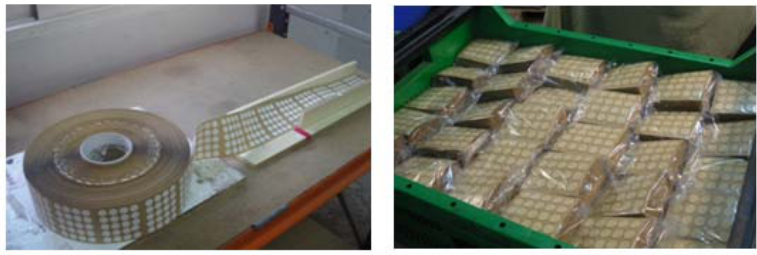
Figure 3. Poka-Yoke designed in WS3 (left) and end product to assemble (right)